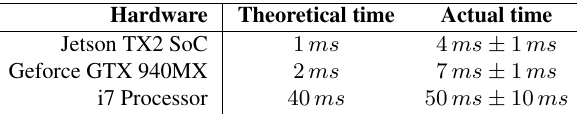
Table 7. Average and standard deviation running time per blob, depending on the hardware.